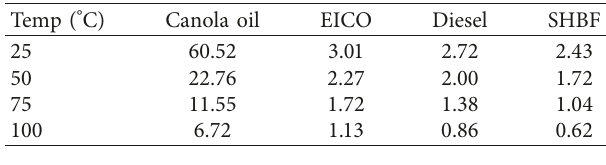
Table 5: Dynamic viscosity (cp) of base fluids at different temperatures.